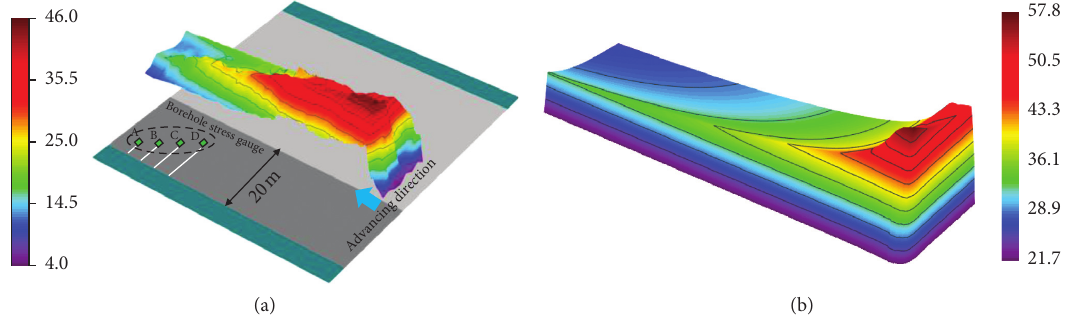
Figure 6: Comparison of on-site measurement results and numerical calculation results. (a) On-site measurement. (b) Numeral